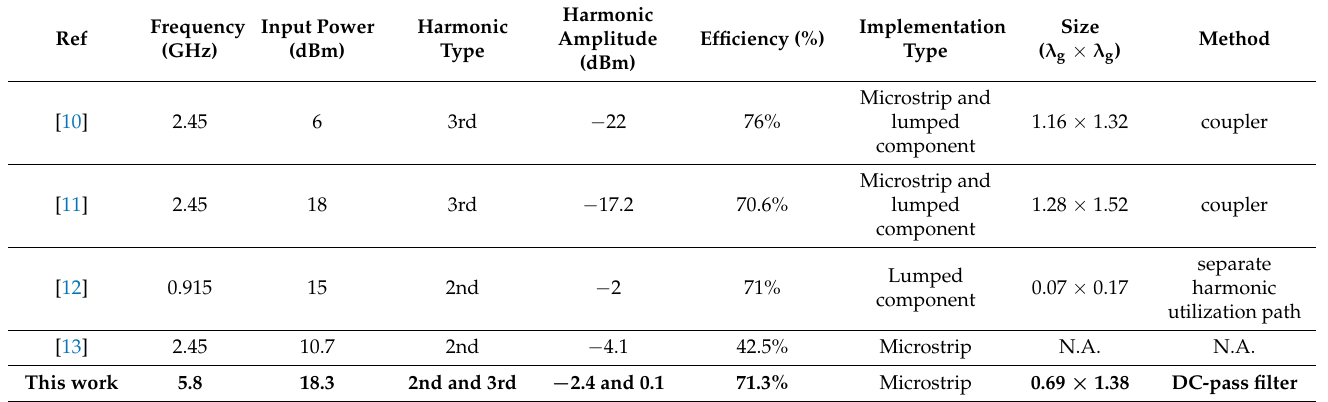
Table 1. Comparison with the prior design methods.